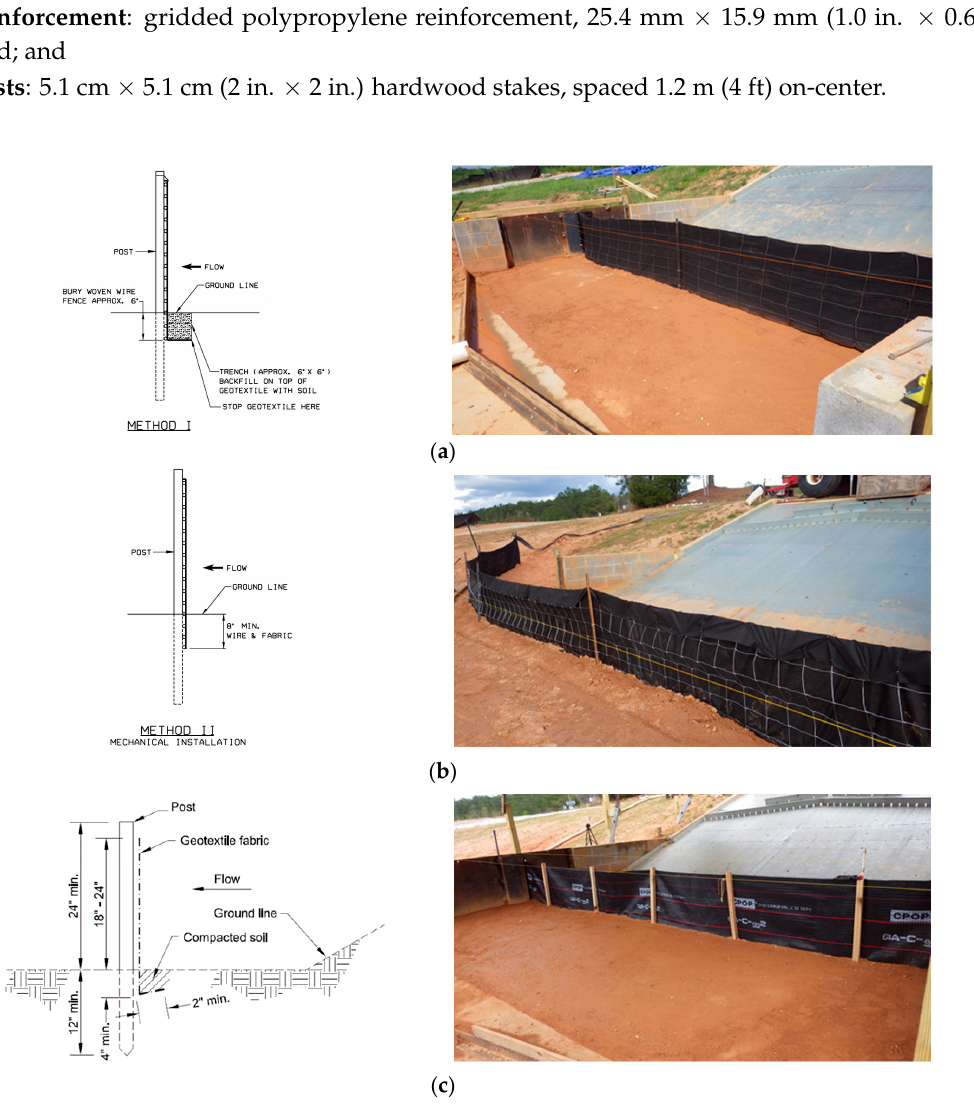
Figure 2. Silt fence installation details, ( a ) ALDOT Trenched Silt Fence [16], ( b ) ALDOT Sliced Silt Fence [16], ( c ) AL-SWCC Trenched Silt Fence [8].